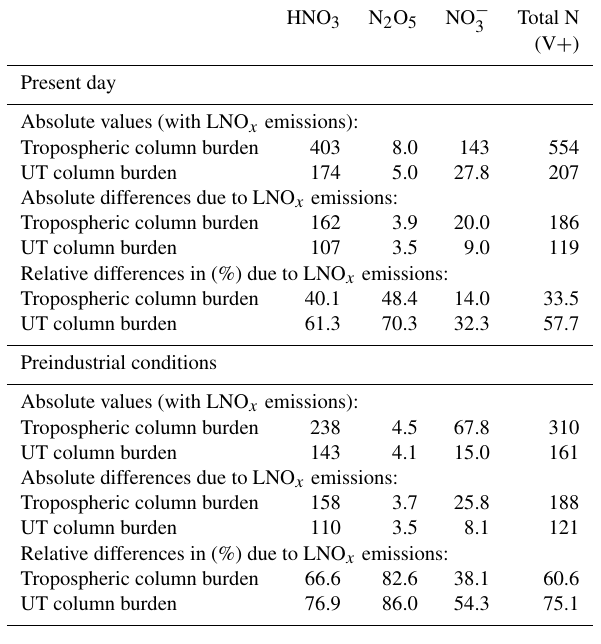
Table 1. Tropospheric and upper-tropospheric burden in the ARG Table 2. CH 4 tropospheric and upper-tropospheric (500hPa to simulation of the important highly oxidised nitrogen species, tropopause) lifetime and absolute change due to LNO x emissions. i.e. gaseous HNO 3 , gaseous N 2 O 5 , aerosol NO − and the sum of 3 those three compounds. All values are given in GgN (except for the relative differences which are provided in %) and are globally and vertically integrated over the whole of the upper troposphere (500hPa up to the tropopause).